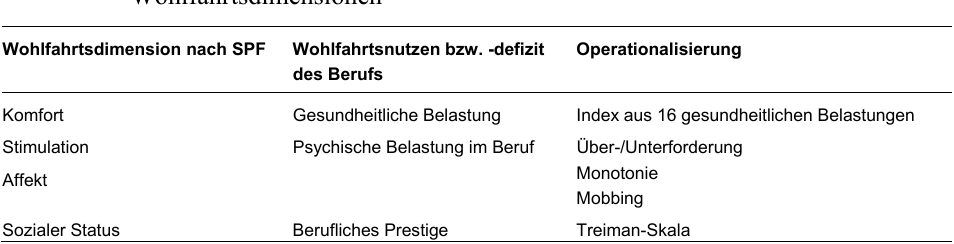
Tabelle 1 : Theoretische Dimensionen und Operationalisierung